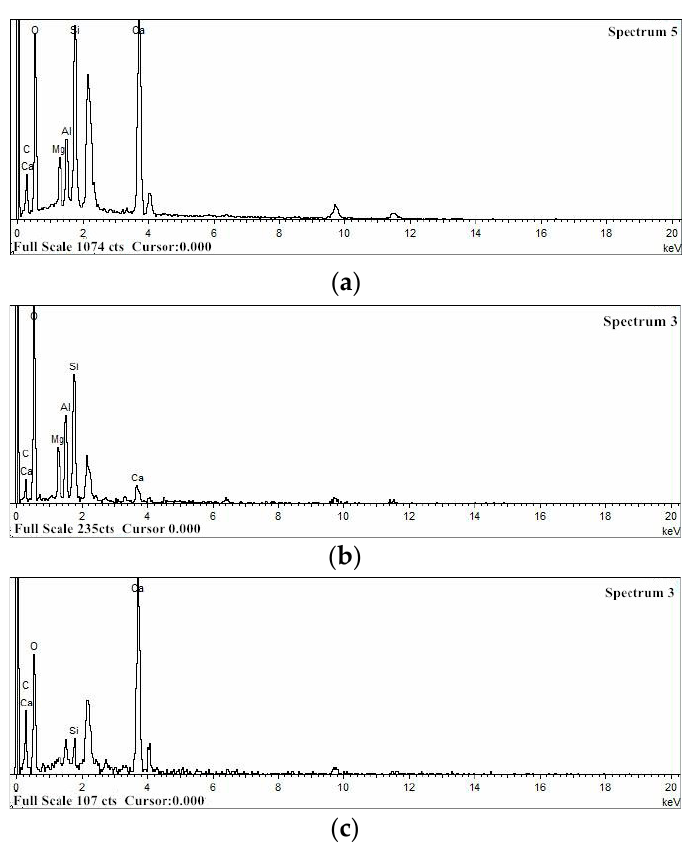
Figure 14. Typical EDS spectra for the marked points in Figure 13: ( a ) group AI (atmospheric environment), ( b ) group WB (water-immersion environment), and ( c ) group HA (saturated-humidity environment). Table 3. Element mass percentage content of the carbonation layer in group AI (wt%).